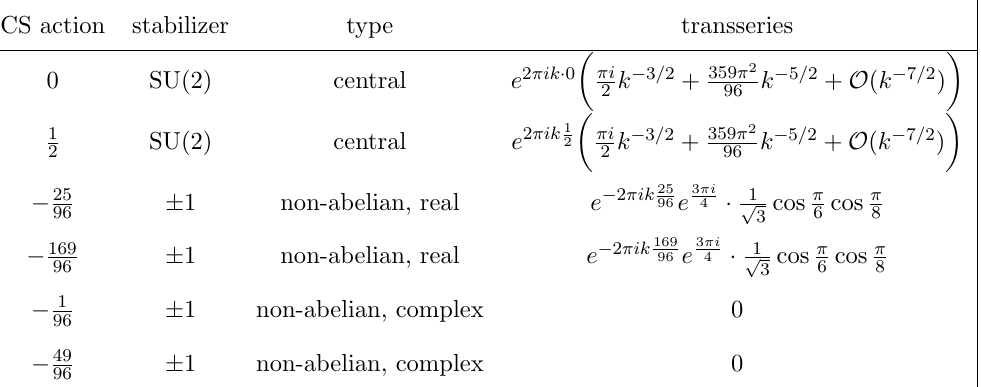
1; 1 ; 1 ; 1 ). 2 3 8 (cid:0)